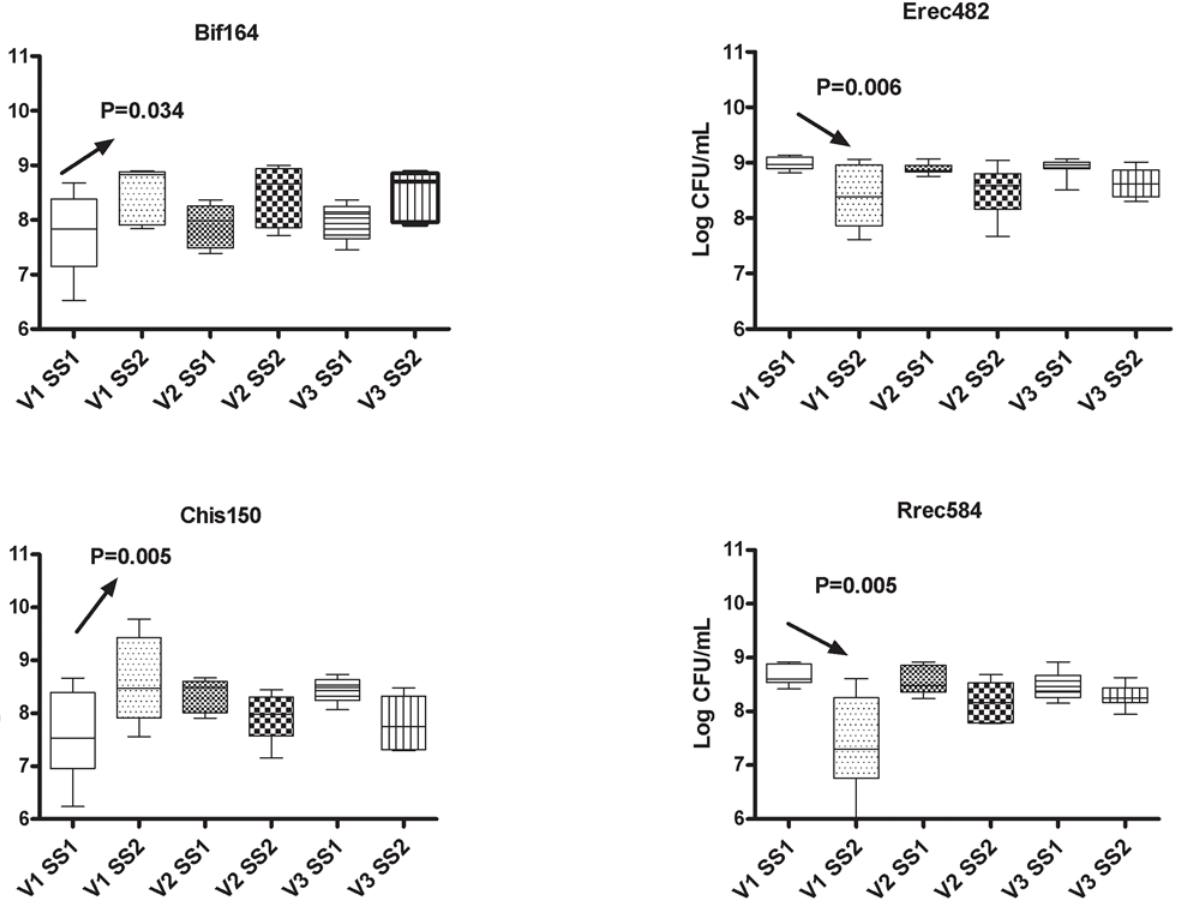
Fig 2. Bacterial groups detected by FISH in culture broths recovered from vessels (V1, V2 and V3) of an in vitro colonic model before (SS1) and after (SS2) daily administration of mixed sugar juice. Results are reported as mean of the data of three colonic models (Log10 CFU/mL) ± standard deviations